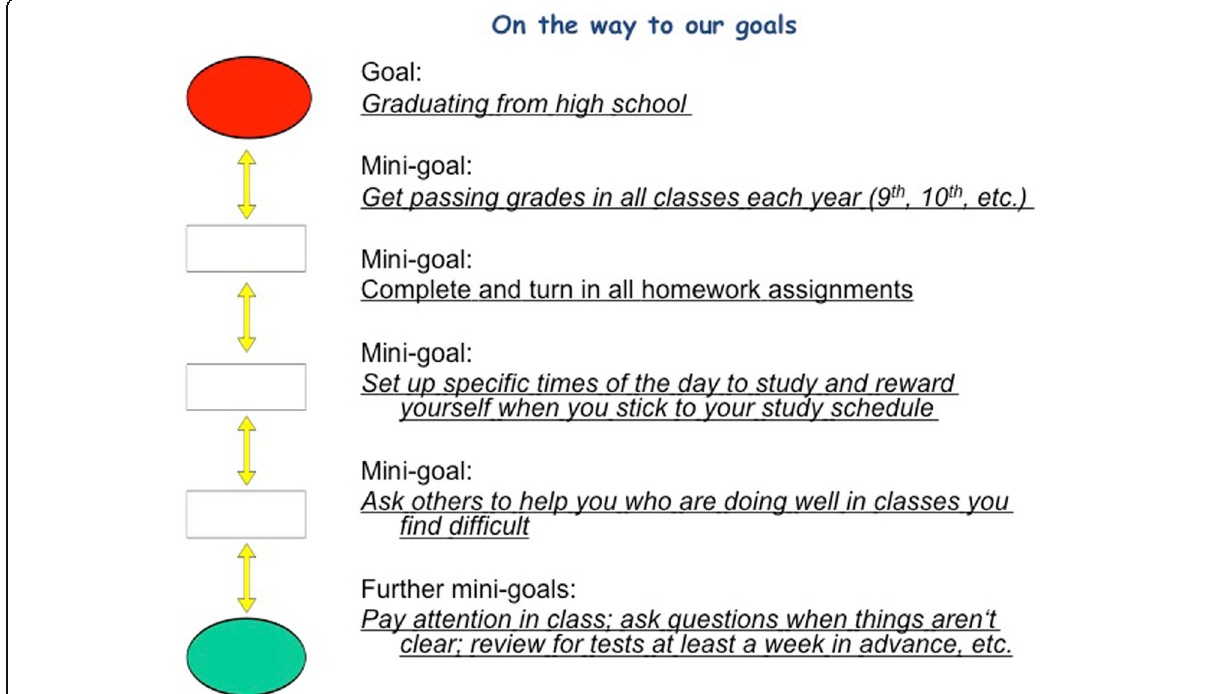
Fig. 4 Example of a completed worksheet used to practice forming